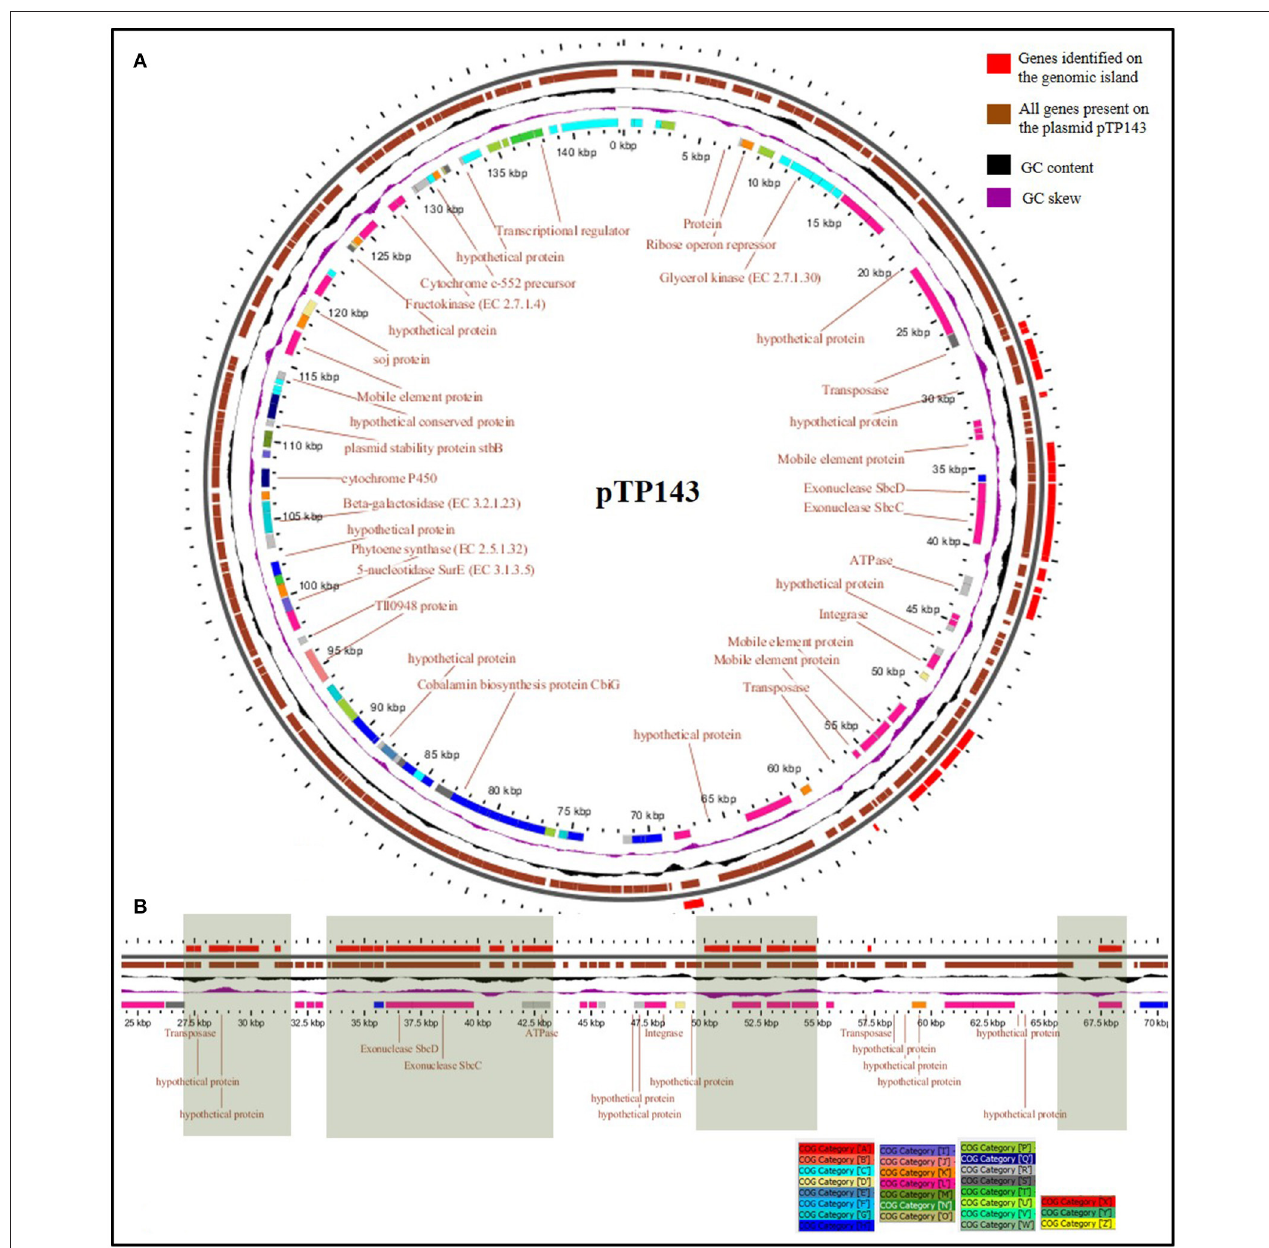
FIGURE 4 | (A) Detailed map of plasmid pTP143 with genes assigned to COG categories and depicted in a color-coded manner. Rings from outside to inside represent positions of genomic islands (GI) (red); coding sequences (brown); GC content (black); GC skew (purple) and COG category assignment (multiple colors according to the color key) (B) GIs found on the megaplasmid pTP143 (linear view) have been highlighted. These regions contain hypothetical protein coding genes, some plasmid specific genes, a toxin-antitoxin system and repair genes. Most of the genes on the GIs were placed into COG category “L” (replication and repair).